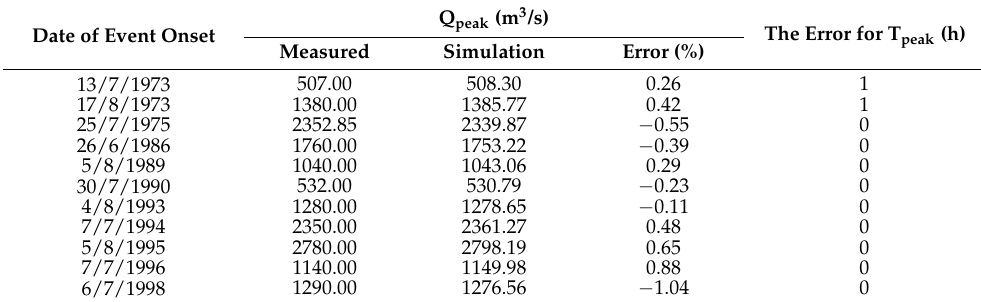
Figure 12. Diagram of the typical flooding process simulation in the JRB; ( a ) Date of event onset is 25/7/1975; ( b ) Date of event onset is 30/7/1990; ( c ) Date of event onset is 7/7/1994; ( d ) Date of event onset is 7/7/1996. Table 6. Model verification results of the flood simulation of the